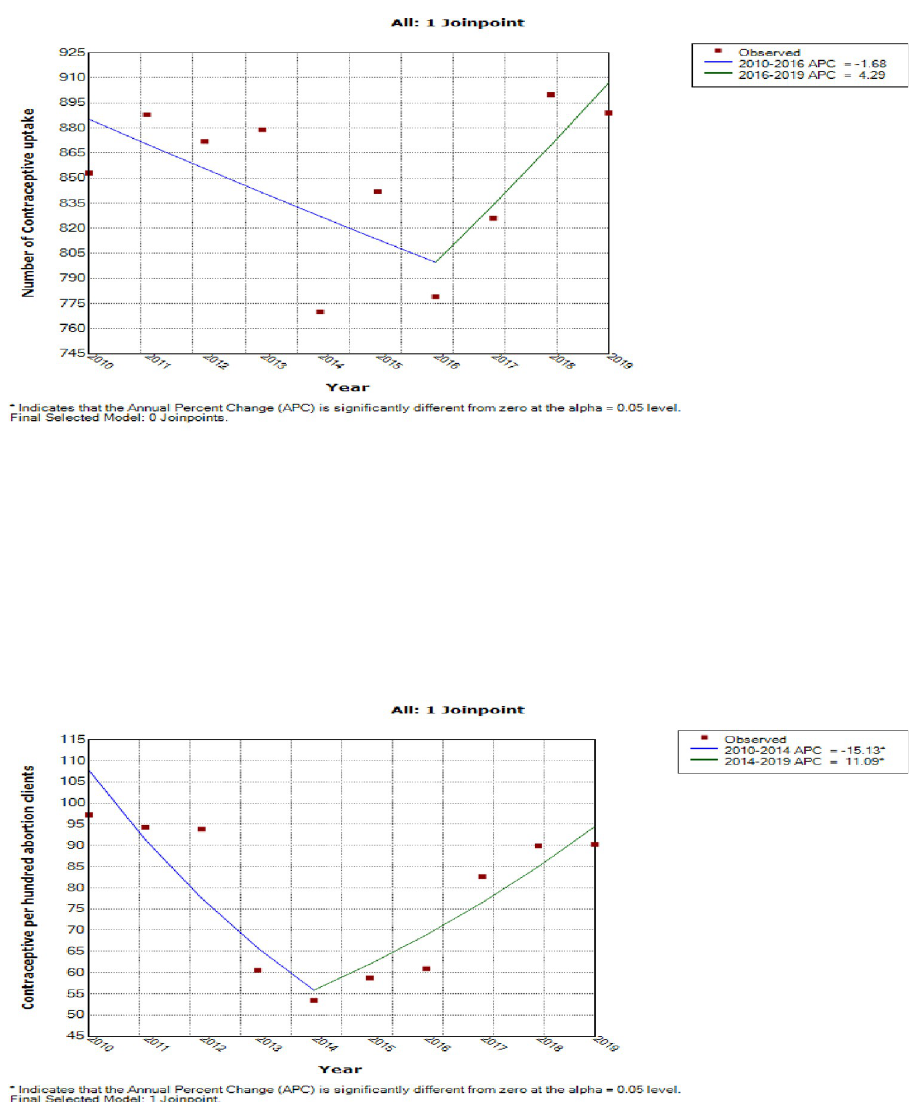
Table 7 also showed that the predicted value of contraceptive uptake was 100.27% and 102.6% based on join point regression modelling and the linear regression modelling. The equation for the prediction line is: Contraceptive prevalence = 8.55 � Year -17177.12 with a high coefficient of determination. (R 2 = 0.9091, P-value = 0.0032). This suggest that the predicted contraceptive uptake should be at the maximal level (100%) by 2020 (Intra-COVID-19 era). The actual contraceptive preva- lence was just minimally lower than the predicted value (100.27% Vs 98.05%) (S3